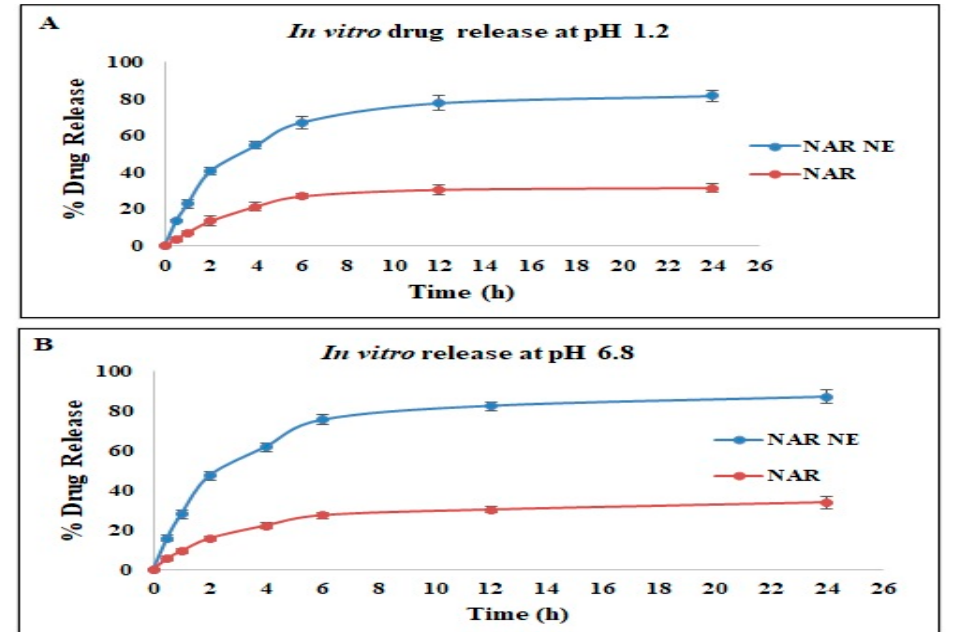
Figure 7. In vitro drug release study of naringenin (NAR) and a naringenin nanoemulsion (NAR-NE) in ( A ) pH 1.2 HCl and ( B ) pH 6.8 PBS. The data are shown as the mean ± SD, n = 3.